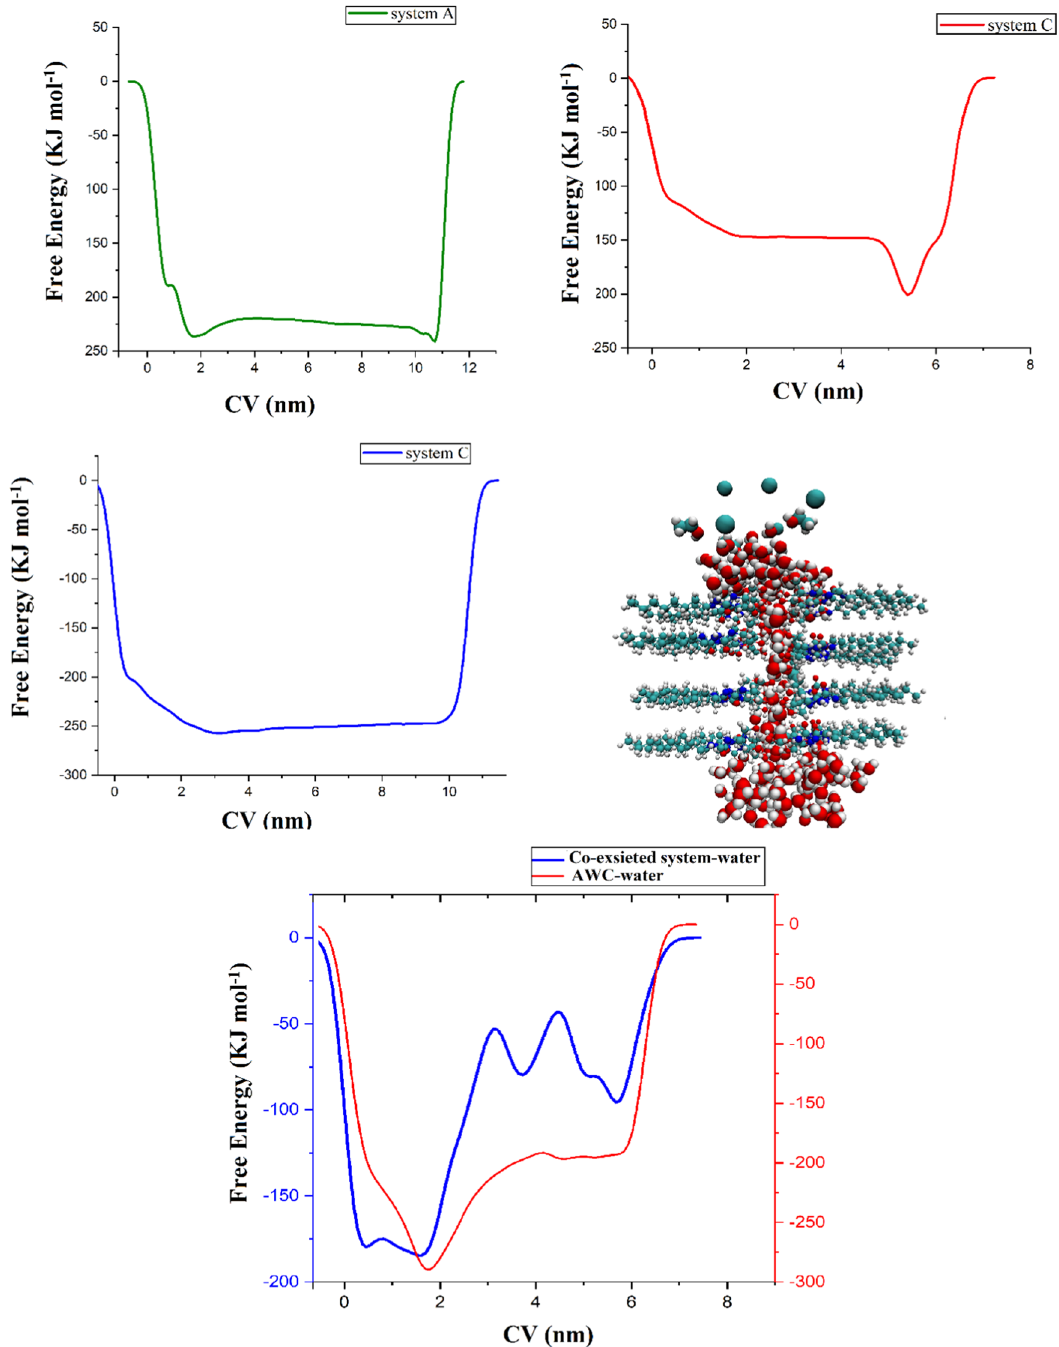
Fig. 10 The FES patterns. For transferring water molecules into the OH-Channel